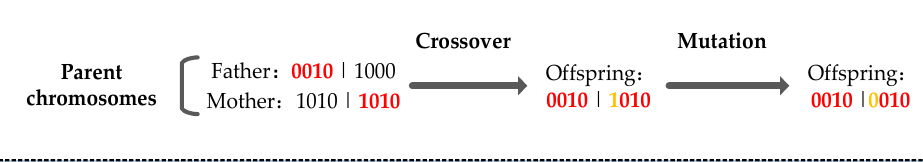
Figure 6. An example of one-point crossover and one-point mutation.